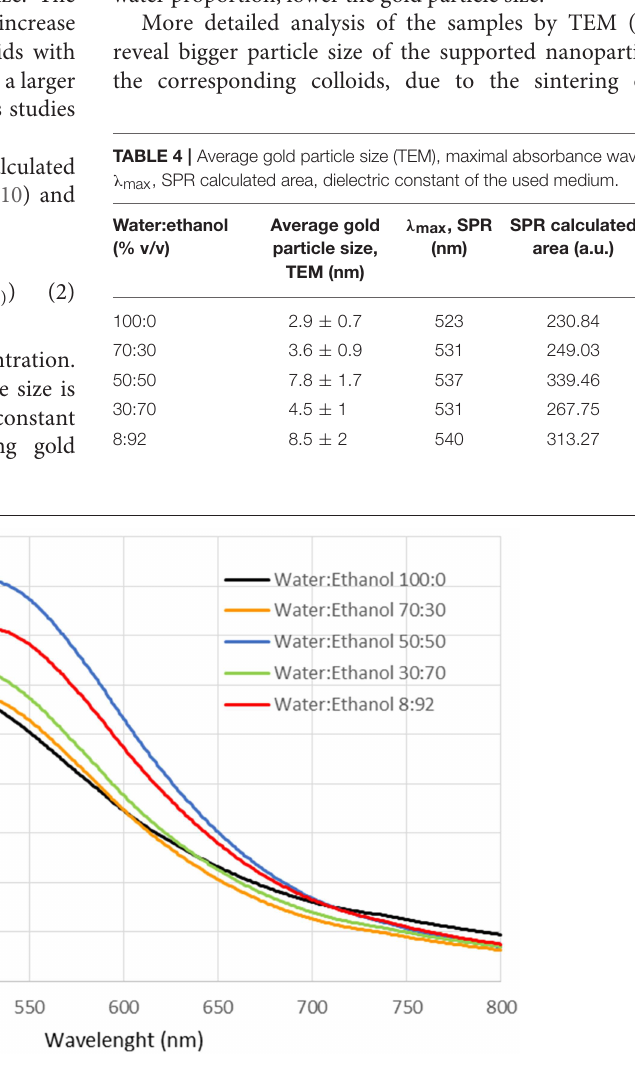
FIGURE 1 | UV-vis spectra of the obtained gold colloids.